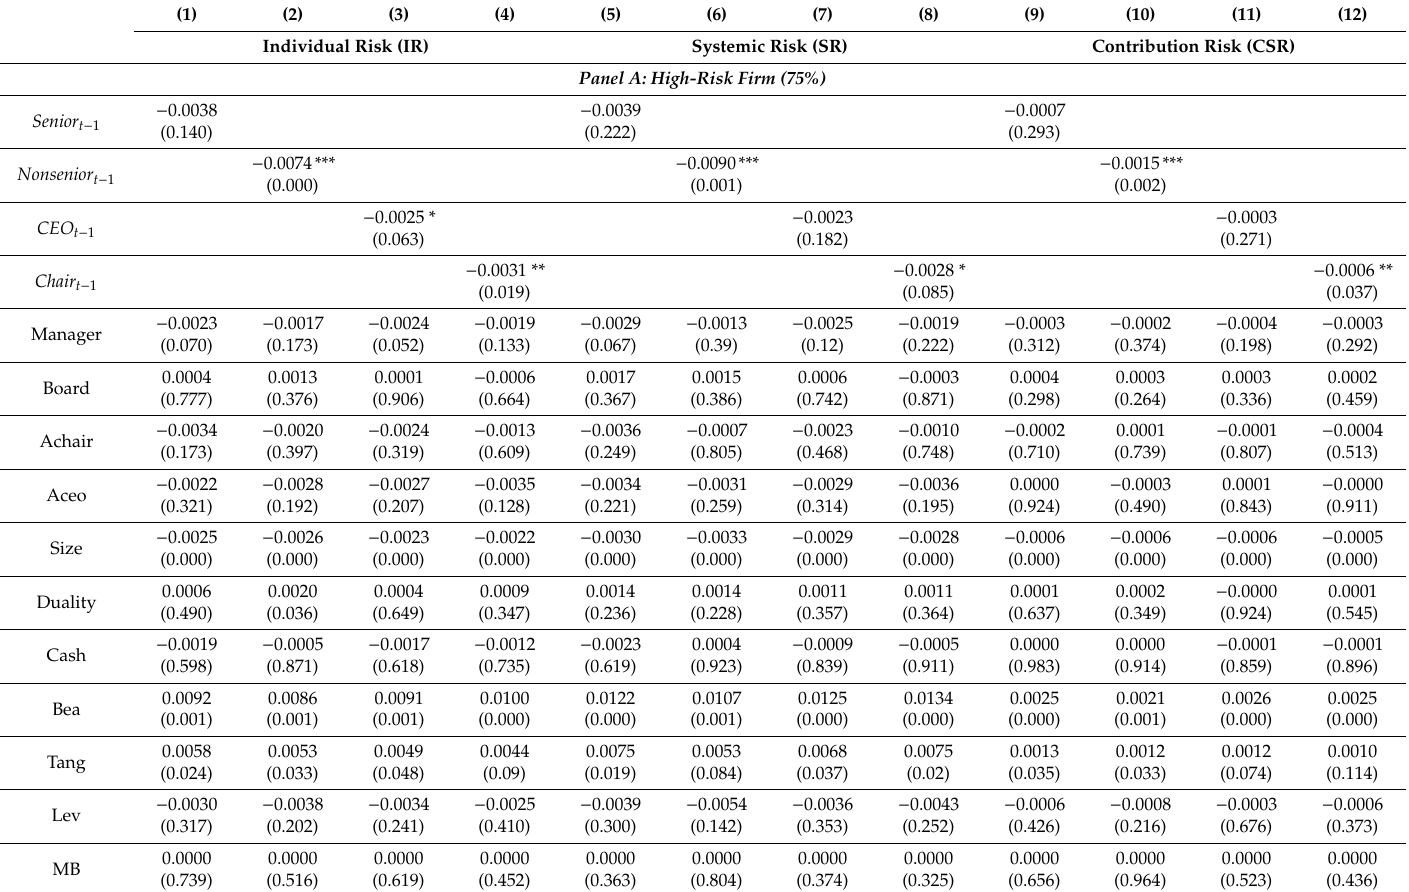
Table 7. Quantile regression of females on board and